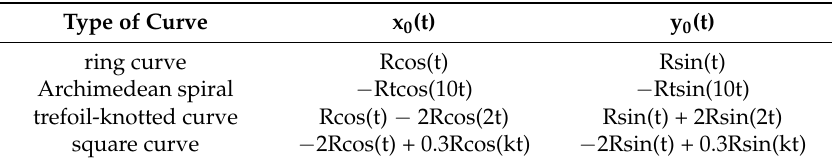
Figure 1. ( a ) Computer-generated hologram (CGH) of a 2D ring curve beam ( b ) Scheme of holographic three-dimensional beam shaping technique. ( c , g ) Reconstructed intensity and phase distribution of the ring curve at the focal plane. ( d , h ) Reconstructed intensity and phase distribution of the Archimedean spiral at the focal plane. ( e , i ) Reconstructed intensity and phase distribution of the trefoil-knotted curve at the focal plane. ( f , j ) Reconstructed intensity and phase distribution of the square curve at the focal plane. Table 1. Parametric expressions for different